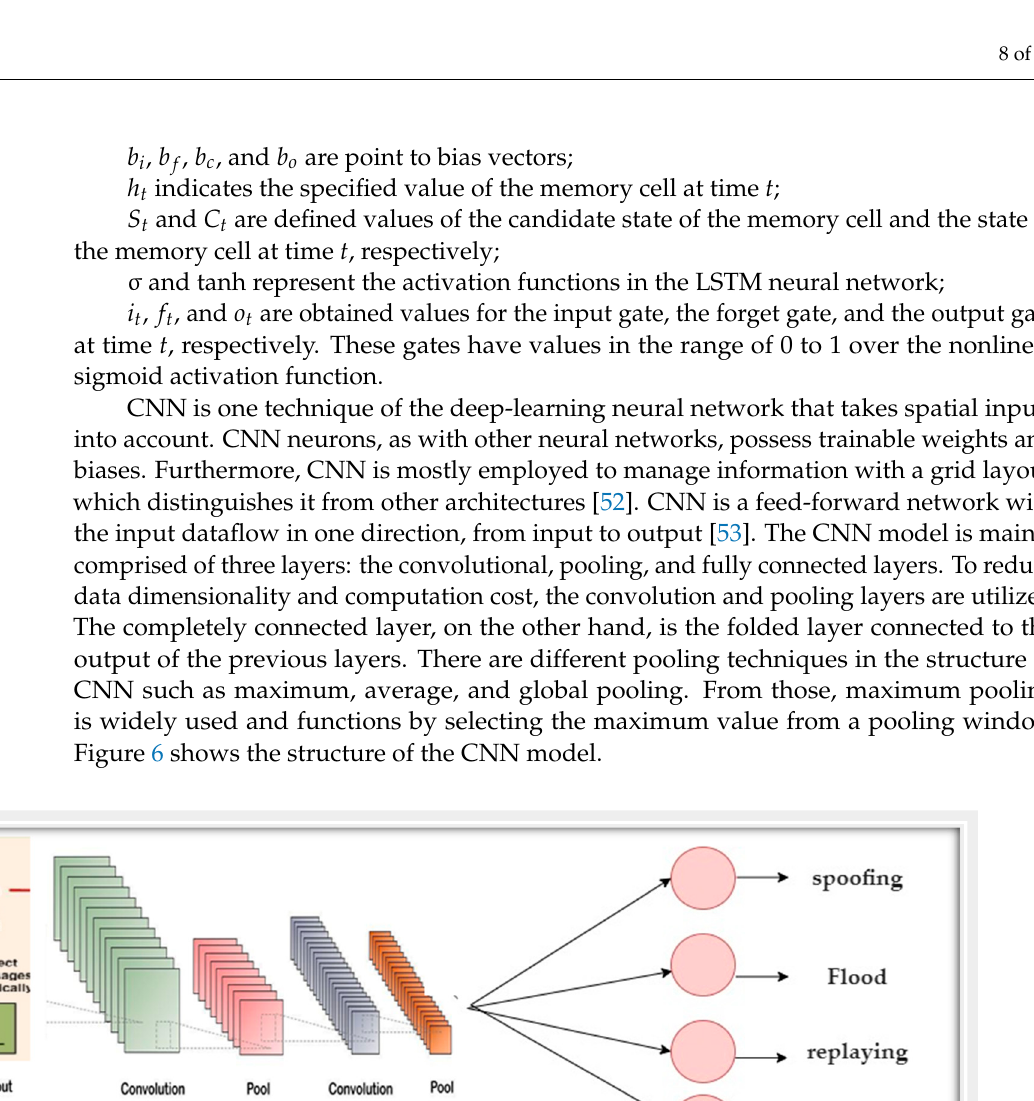
Table 4. Parameters of the proposed model.